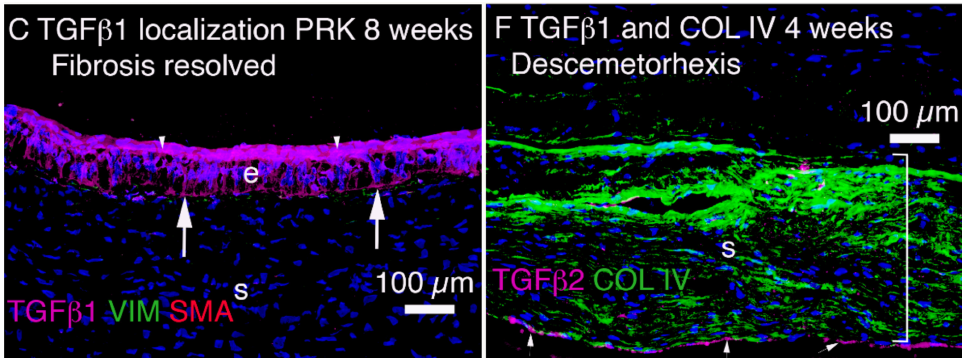
Figure 5. Localization of TGF beta-1 and TGF beta-2 in unwounded and wounded rabbit corneas. ( A ) TGF beta-1 (TGFb1) is produced (large arrows) in corneal epithelium (e) and endothelium (large arrowheads) and is also present in tears and aqueous humor in the anterior chamber (AC) [5]. In unwounded cornea, collagen type IV (COL IV) is detected in the EBM (small arrows) and in DBM (small arrowheads). ( B ) TGFb2 is not expressed in the corneal epithelium or corneal endothelium (arrowhead indicates a small area of visible corneal endothelium) but is present in tears (produced by accessory and main lacrimal glands) and in the aqueous humor. ( C ) In corneas that do not develop fibrosis or in corneas that develop fibrosis that subsequently resolves, as in this cornea at 8 weeks after PRK, TGFb1 is retained from entering the stroma by the fully regenerated EBM (arrows) and regeneration of the superficial epithelial barrier function (EBF, small arrowheads). Note no SMA-positive myofibroblasts remain, but a few vimentin-positive, SMA-negative corneal fibroblasts persist just posterior to the EBM. ( D ) In a cornea that develops fibrosis 4 weeks after PRK, high levels of TGFb1 (and TGFb2 not shown) accumulate throughout the epithelium (e) and into the anterior stroma (s) without evidence of EBM regeneration or EBF. Numerous SMA-positive myofibroblasts (arrows) and SMA-negative, vimentin-positive corneal fibroblasts are present in the sub-epithelial stroma. ( E ) The same section as in D, but showing only TGFb1, highlights the penetration of the TGFb1 into the anterior stroma (arrows), although some stromal cells also produce limited amounts of TGFb1 [5]. ( F ) In a rabbit cornea at 4 weeks after Descemetorhexis removal of an 8 mm disc of DBM and corneal endothelium, TGFb1 (arrows) is localized at the posterior corneal surface still devoid of DBM or endothelium. Much of the posterior stroma (bracket) contains collagen type IV (COL IV) not associated with DBM that is upregulated in corneal fibroblasts by TGFb1. Since COL IV directly binds TGFb1 in competition with cognate TGF beta receptors, it is hypothesized this COL IV is produced to downregulate TGFb1 effects on cells in the posterior stroma, including myofibroblast precursors [7]. A similar upregulation of non-EBM COL IV occurs in the anterior stroma after injuries such as PRK. Panels A and B are previously unpublished images from study de Oliveira et al. Exp Eye Res, 2021;202:108325. Panels C, D and E reprinted with permission from de Oliveira et al. Exp Eye Res, 2021;202:108325. Panel F reprinted with permission from Sampaio LP et al. Exp Eye Res.